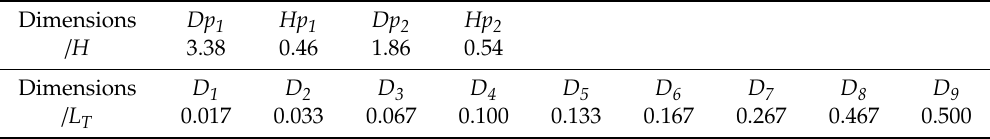
Table 3. Dimensions of locations of pressure measuring points.